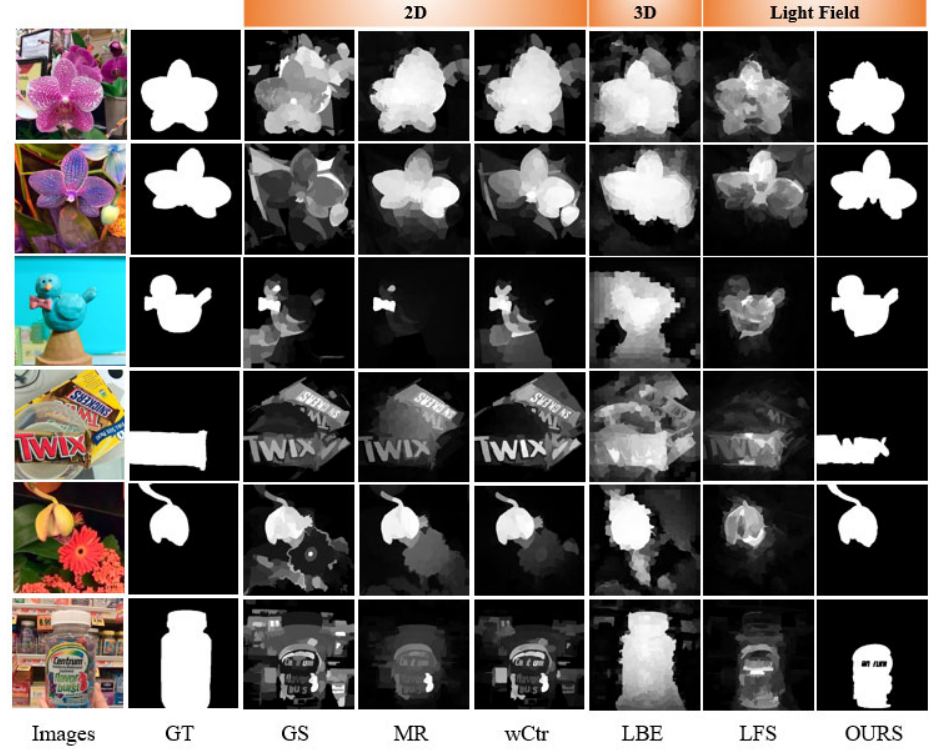
Figure 6. The saliency map obtained by different salient object detection methods.